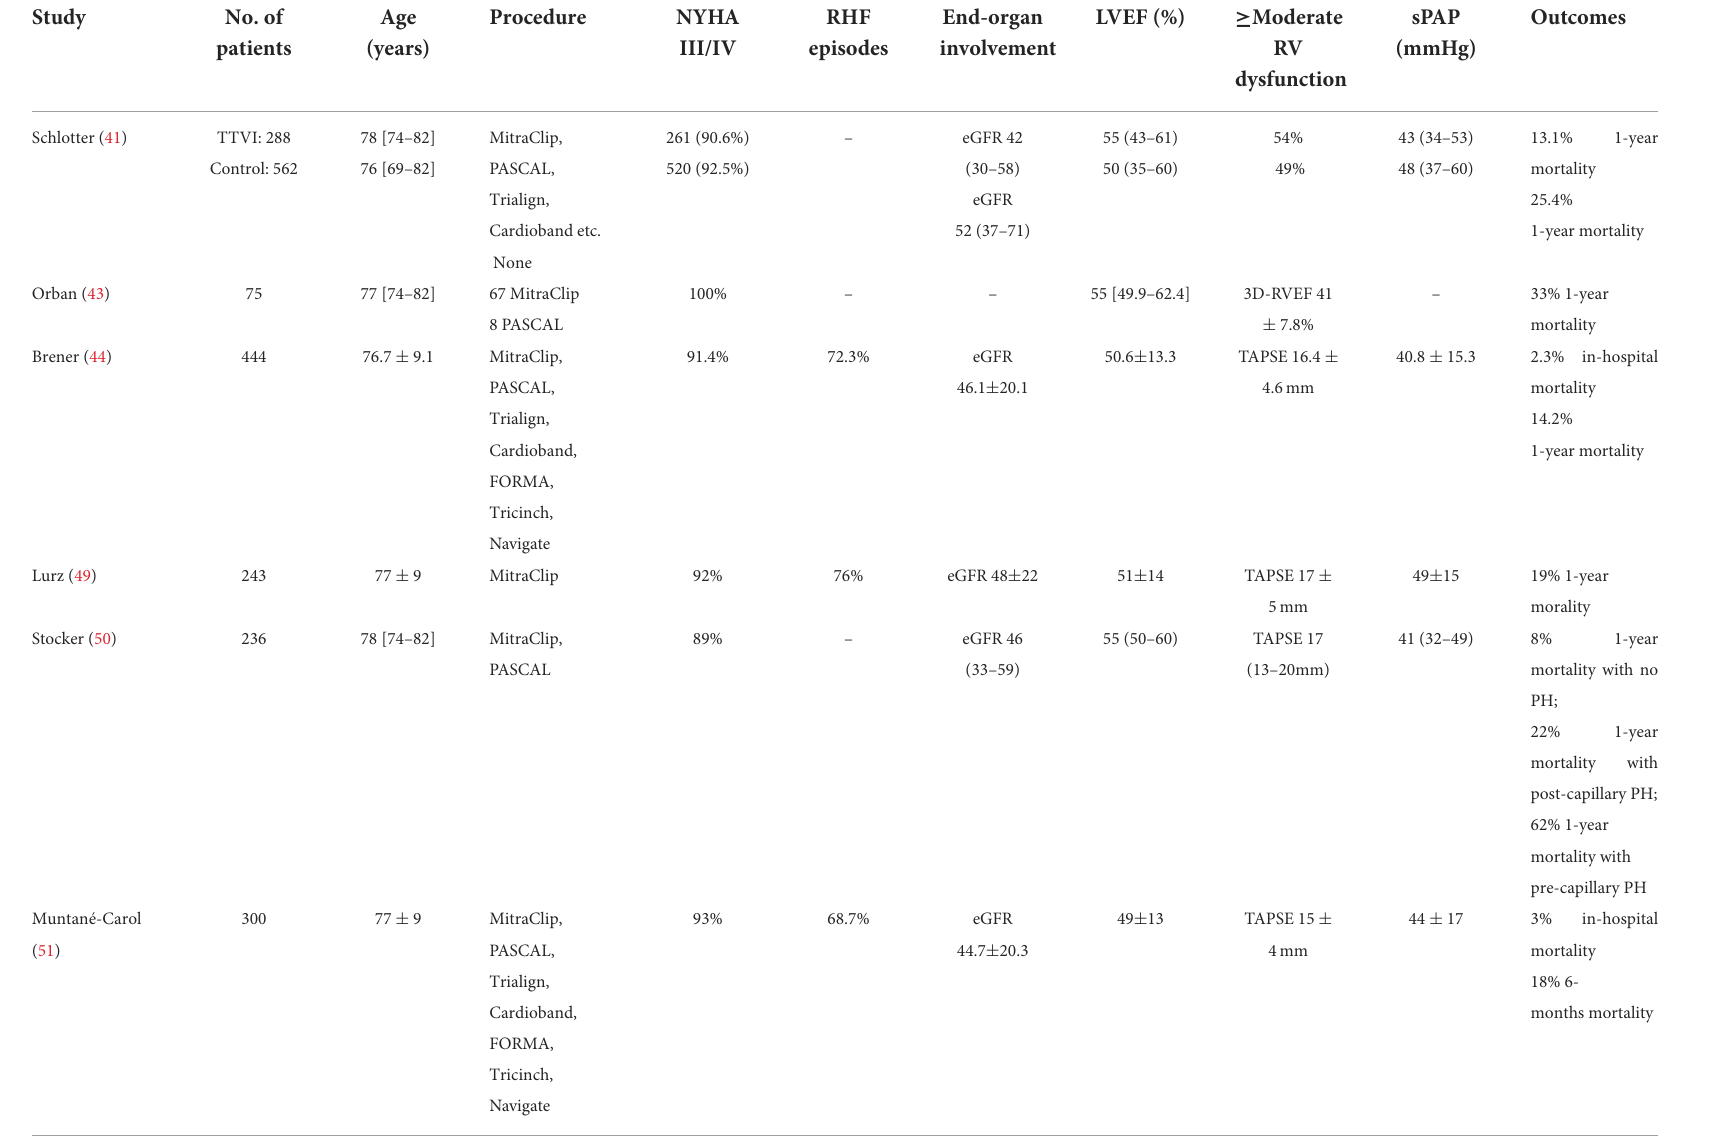
TABLE 2 Characteristics of the transcatheter studies in the